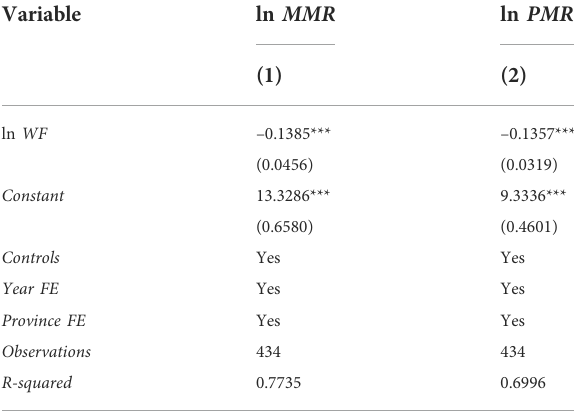
TABLE 4 Robustness tests for narrowed dictionary.